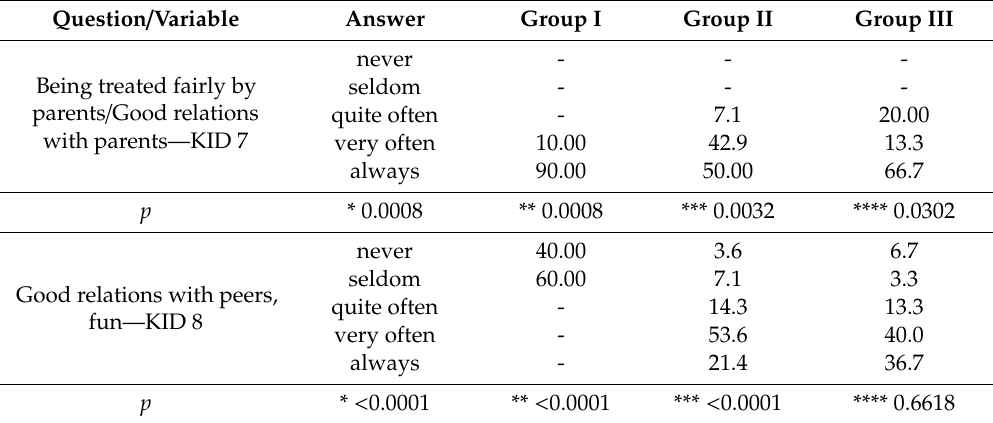
Table 8. Relationships with parents and peers. The percentage of respondents providing a given answer